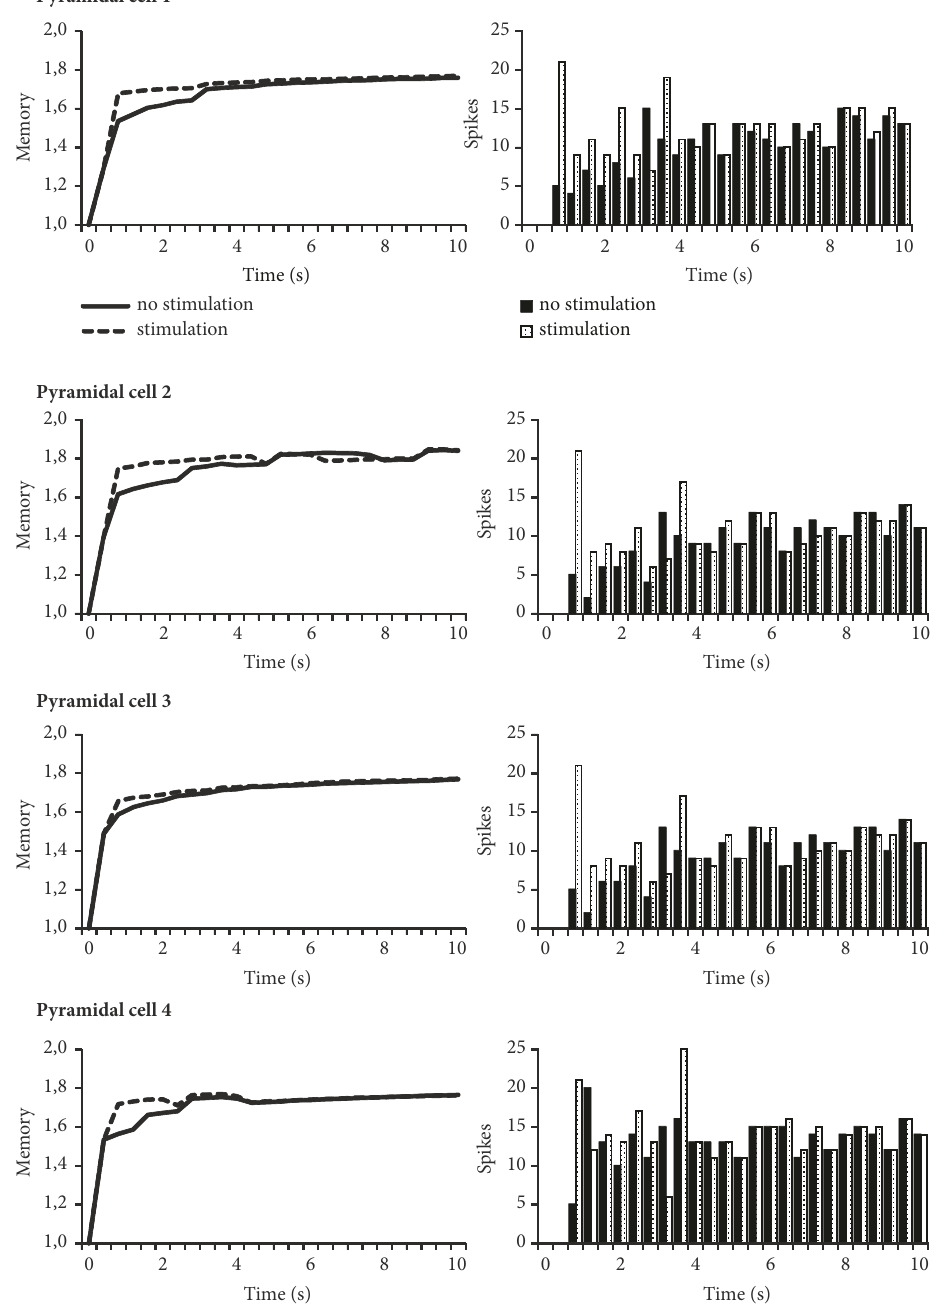
Figure 5: Comparison of memory during the simulation without and with LTP inducing protocol. On the left, relationship between memory function without and with LTP inducing protocol. On the right, histograms reflect number of firing spikes during 10s simulation without and with LTP inducing